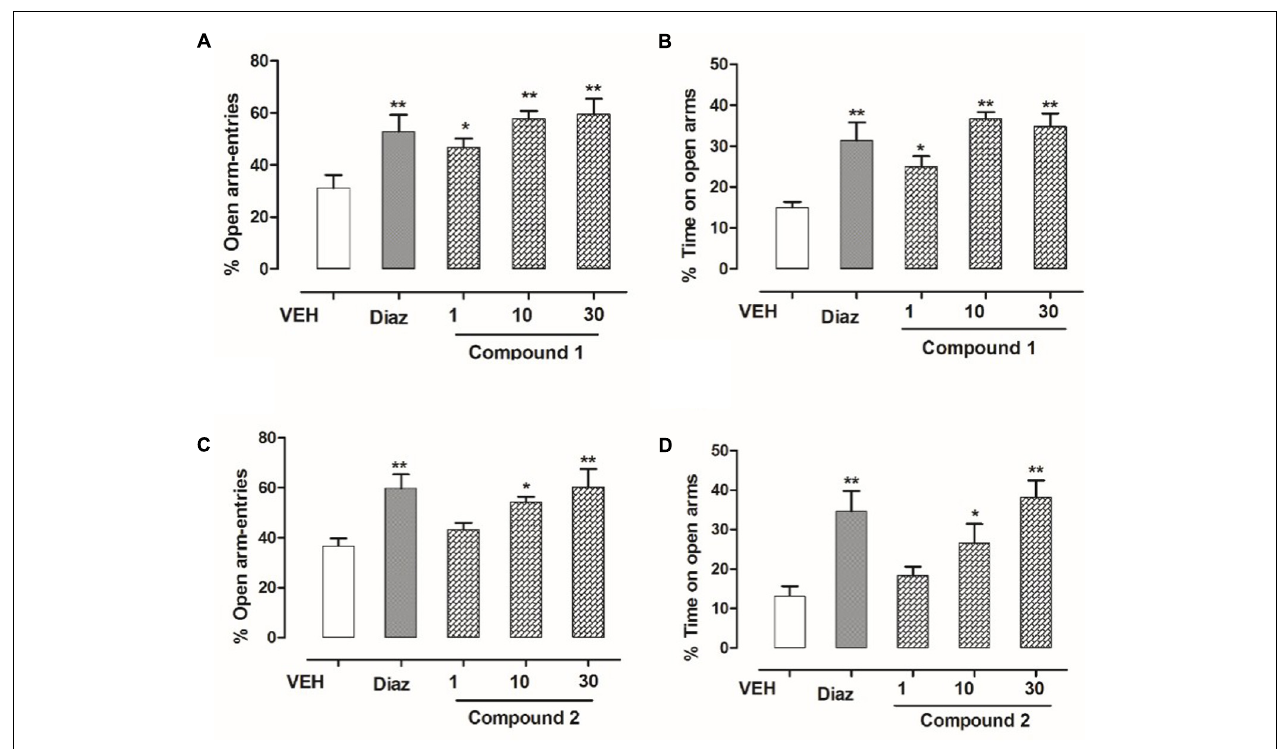
FIGURE 3 | Effect of compounds 1 and 2 and diazepam on the behavior of mice in the EPM. (A) % open-arm entries, (B) % time spent in open arms registered over a session of 5 min, after 20 min of an i.p. injection of compound 1 (1, 10, and 30 mg/kg), diazepam (1 mg/kg), or vehicle. (C) % open-arm entries (D) % time spent in open arms registered over a session of 5 min, after 20 min of an i.p. injection of compound 2 (1, 10, and 30 mg/kg), diazepam (1 mg/kg), or vehicle. Column represents mean ± SEM ( n = 6/group). ∗ P < 0.05, ∗∗ P < 0.01, compared with vehicle group using one-way ANOVA followed by Dunnett’s